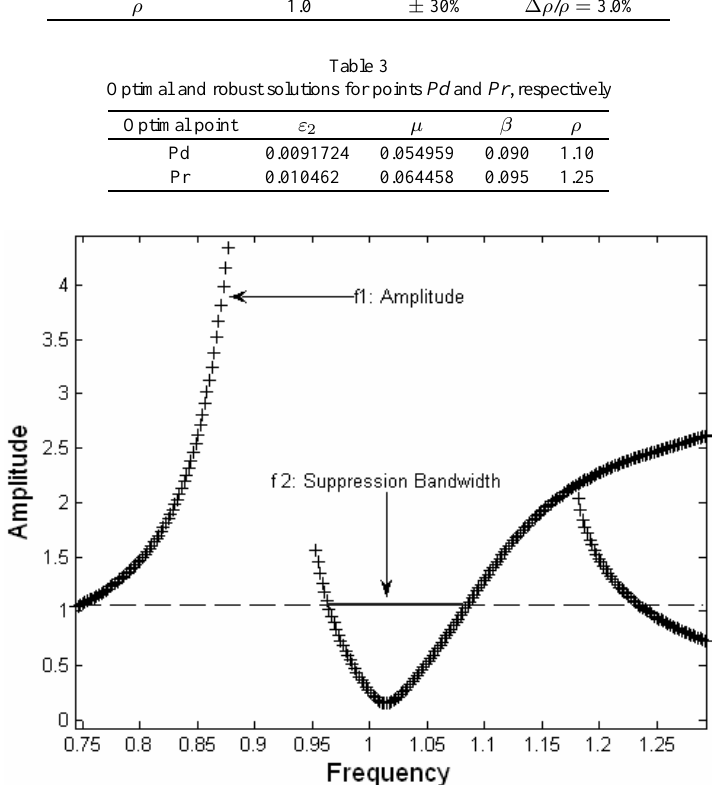
Fig. 9. Representation of the objective functions f 1 and f 2